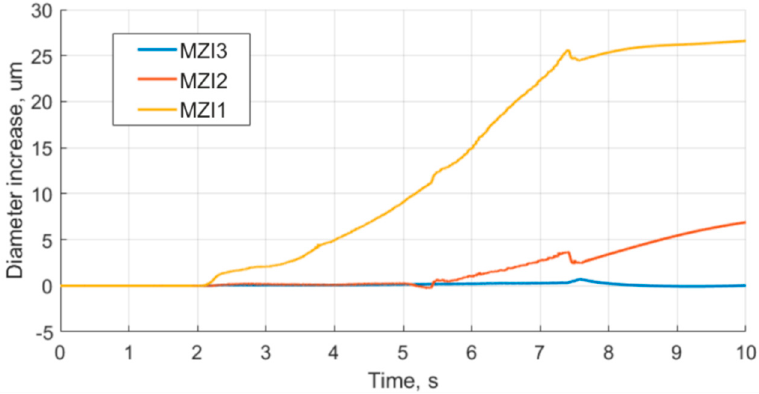
Figure 8. Plots of housing diameter increase.